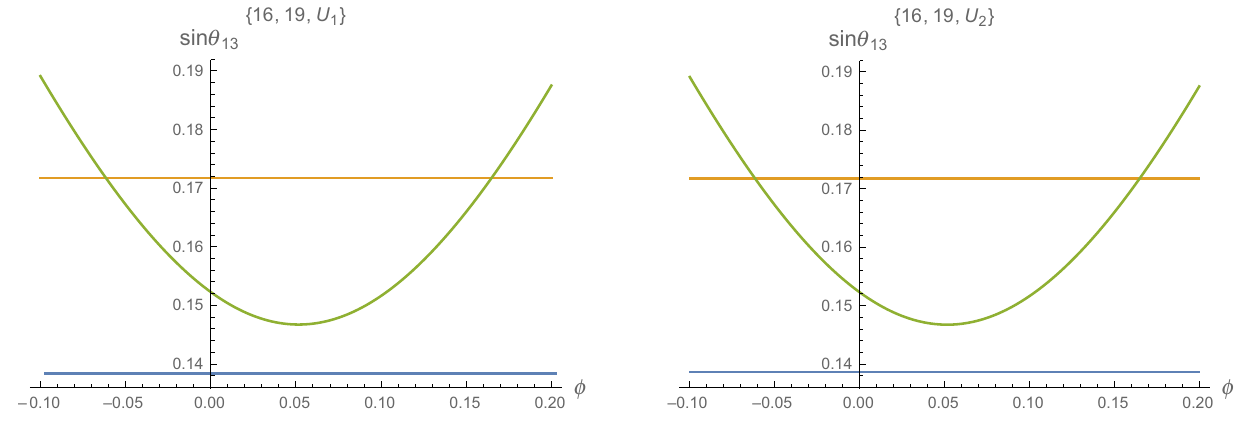
Fig. 2 The acceptable range of sin θ 13 vs. the angle ϕ for the pair el 2 ( 16 ) el 3 ( 19 )